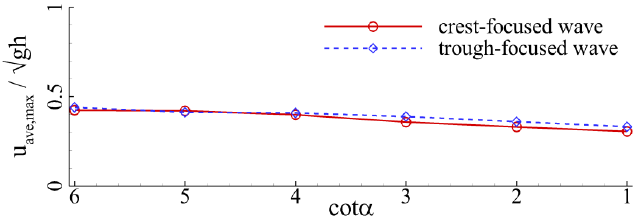
Figure 45. Maximum depth-averaged velocity at the reef crest versus the forereef slope.